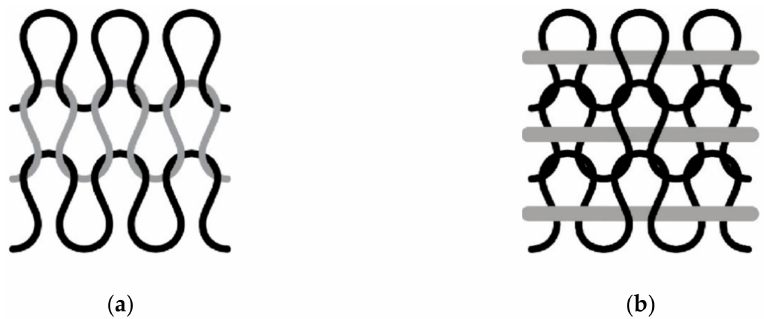
Figure 1. ( a ) Example of a knitted structure with loops (single jersey); and ( b ) the same knitted structure with an inlay yarn (the ground yarn making loops is shown in black and the inlay yarn in grey).